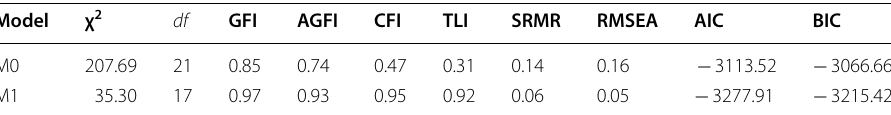
Table 3 SEM fit index summary